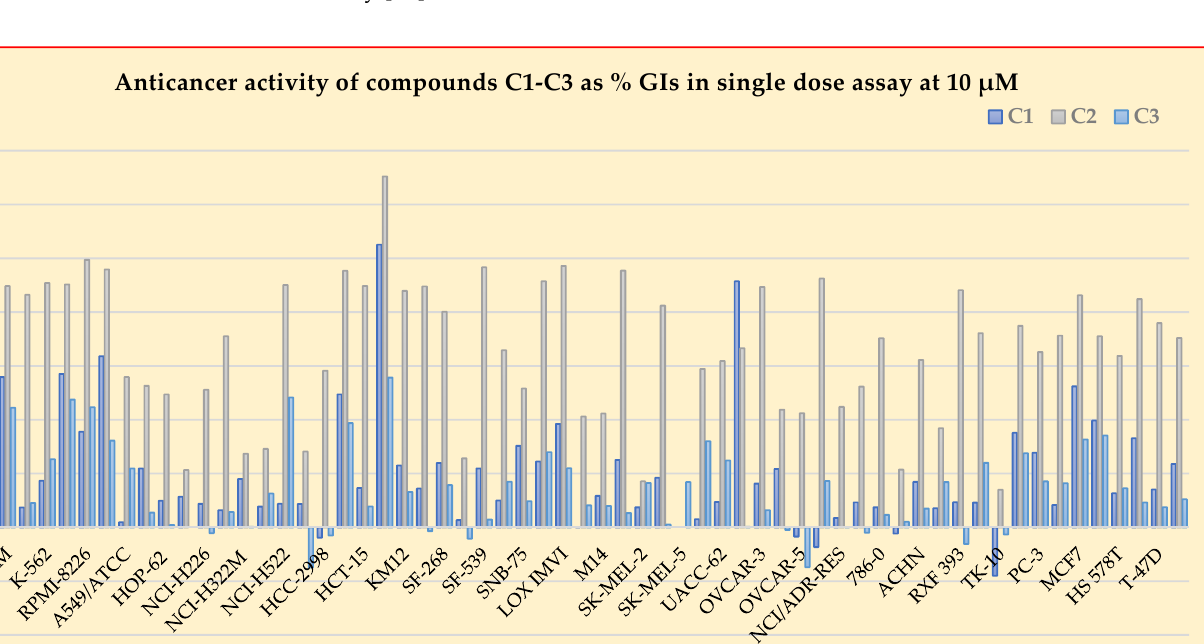
µM) among breast cancer cell lines. The compound C2 exhibited non-selectivity against all the nine panels of cancer cell lines with a selectivity ratio (SR) ranging between 0.73 and 1.35 as the value of SR was found to be less than three (Table 1) [51]. The anticancer activity of compounds C2 against nine panels of 58 NCI cancer cell lines in terms of GP and Log 10 molar concentration are shown in Figure 5.